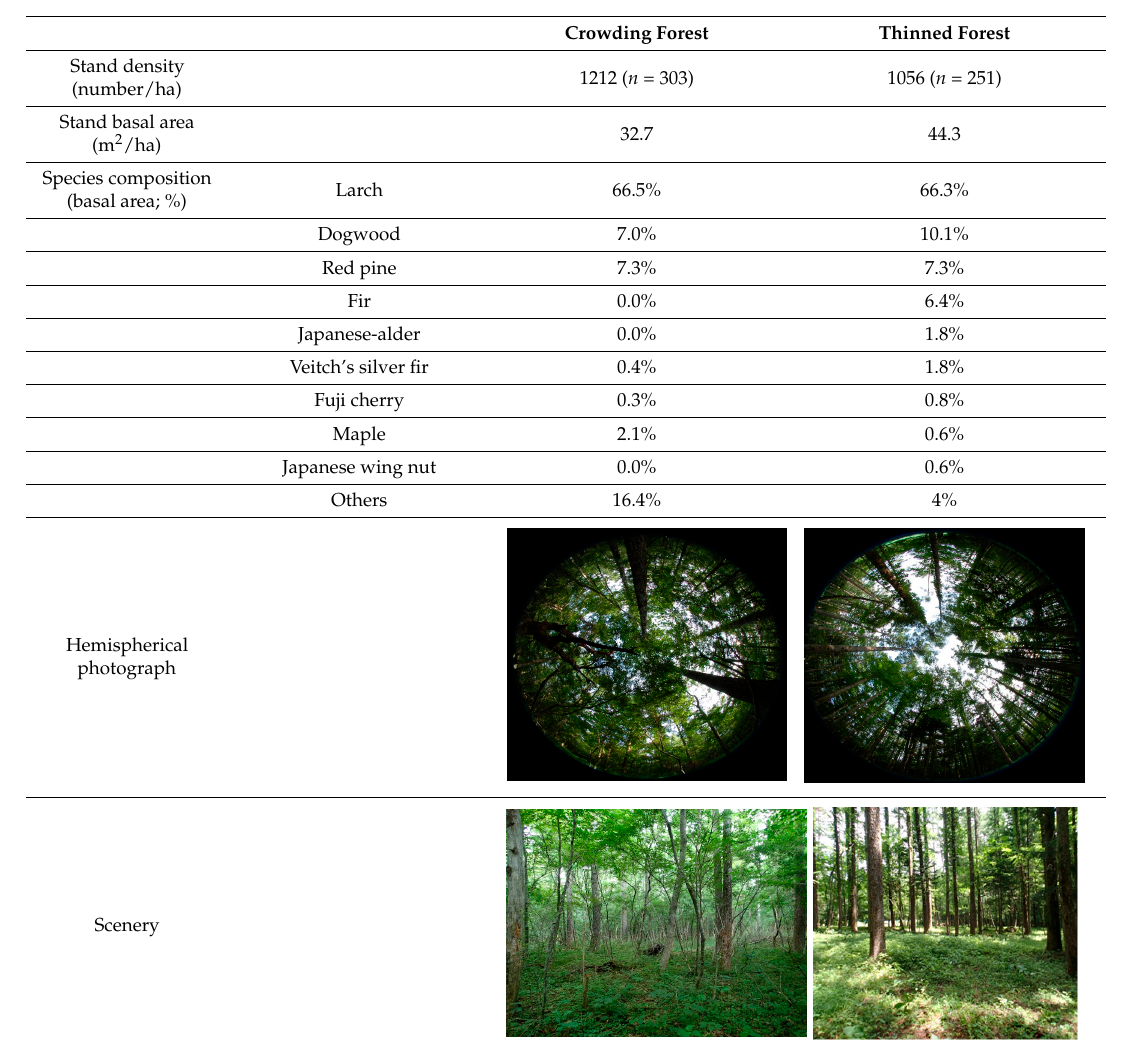
Table 2. Perspectives of the Crowding and Thinned Forest Settings.